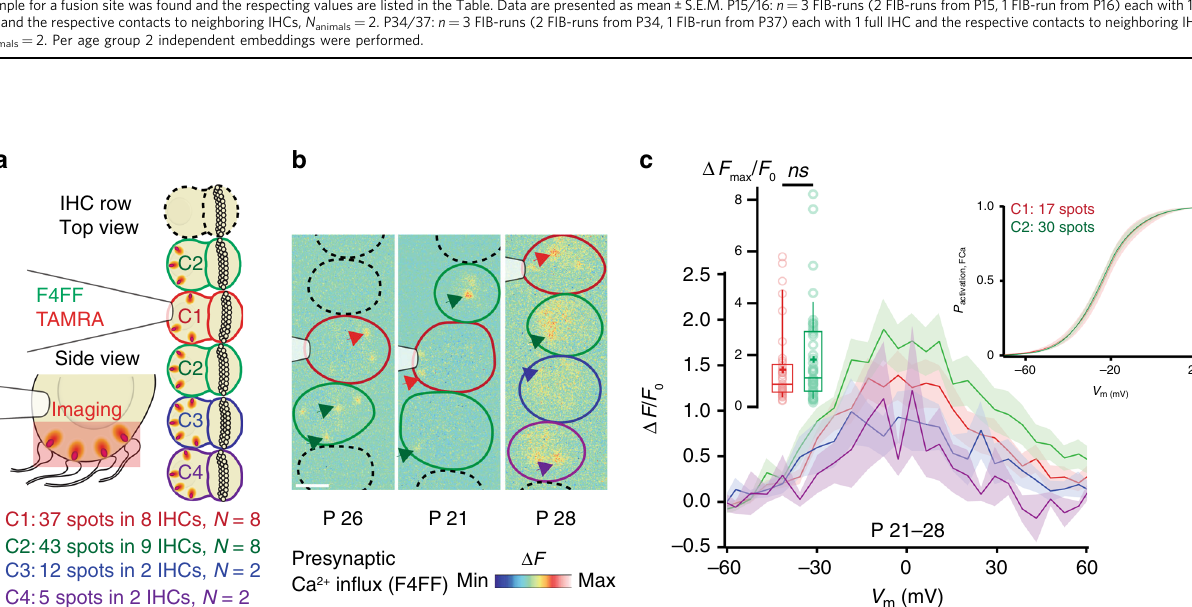
Fig. 7 Collective synaptic activity in IHC mini-syncytia. a Coupled IHCs (delineated in color) were patch-clamped and loaded with the calcium indicator Fluo-4FF (F4FF) and TAMRA- fl uorescent CtBP2-binding peptide. C1 (red) is the patched IHC, C2 (green) are coupled and adjacent to C1, C3 (blue) is coupled to C2 and C4 (violet). The red box shows the imaging plane. b Ca 2 + -signals co-localizing with the presynaptic ribbons are observable. Example Δ F/F 2 + -increments (black arrows) of 2 (left), 3 (middle), and 4 (right) coupled IHCs. Non-coupled IHCs are 0 pictures from a single plane of the Ca delineated in dashed lines. c The graph displays the fl uorescence versus voltage-relationship ( Δ F/F 0 versus depolarization level), showing presynaptic activity in the coupled IHCs. Left inset show individual values and percentiles (10th, 25th, 50th, 75th and 90th) of Δ F max /F 0 of synapses in C1 (37 spots in 8 IHCs, N = 8) and C2 (43 spots in 9 IHCs, N = 8). Means are indicated as crosses. Right inset displays averaged fractional activation curves of a subset of the spots for which the Δ F/F 0 could be fi tted faithfully (C1: 17 spots in 7 IHCs, N = 7; C2: 30 spots in 8 IHCs, N = 8). Mean (line) ± S.E.M. (shaded areas) are displayed. IHC inner hair cell. Scale bar: b = 5 µ